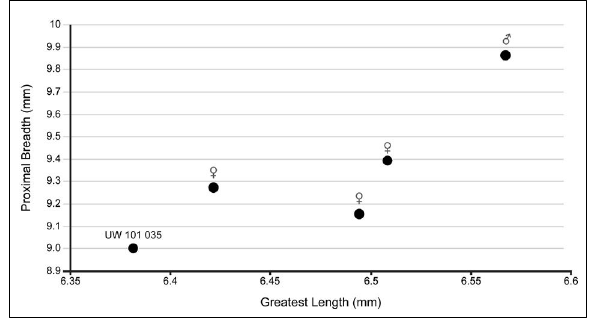
figure 3: Tarsometatarsus proximal breath and greatest length measurements (in mm) for U.W. 101 035 plot closer to extant female specimens of Tyto alba